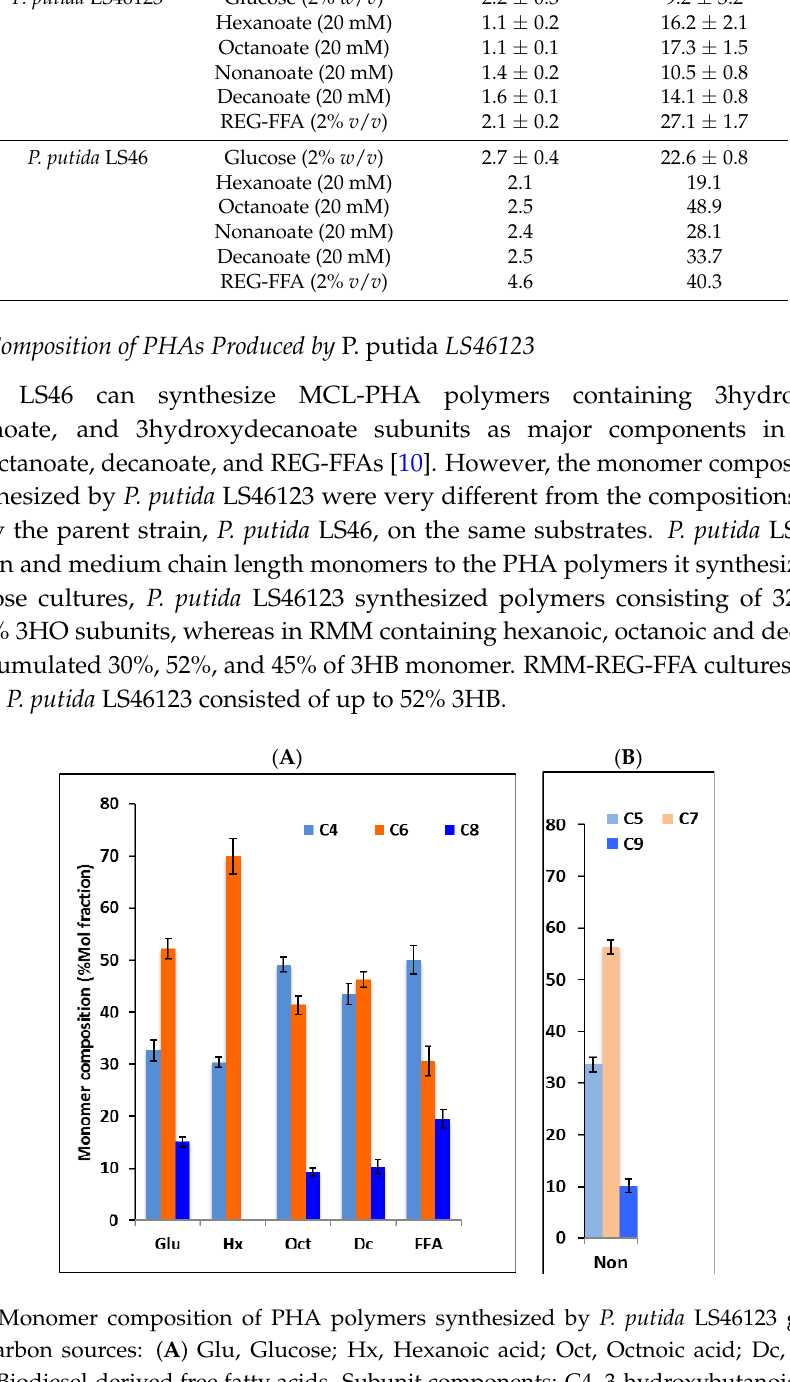
Strains Carbon Source Strains